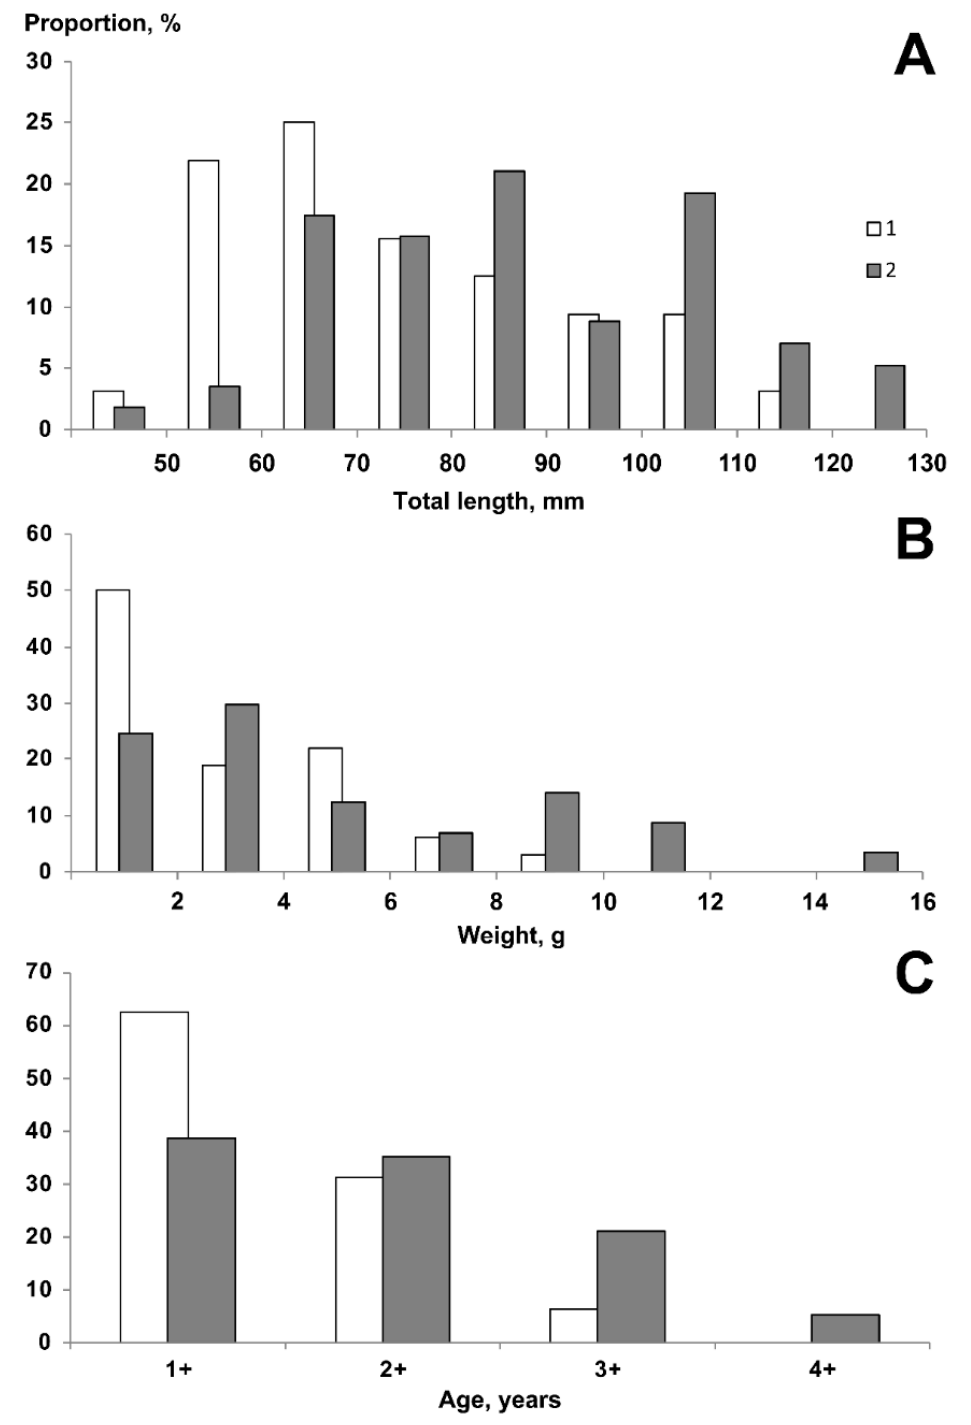
Figure 7. Size ( A ), weight ( B ), and age ( C ) compositions of male (1) and female (2) ribbed sculpin Triglops pingelii in the Kara Sea, September 2019.